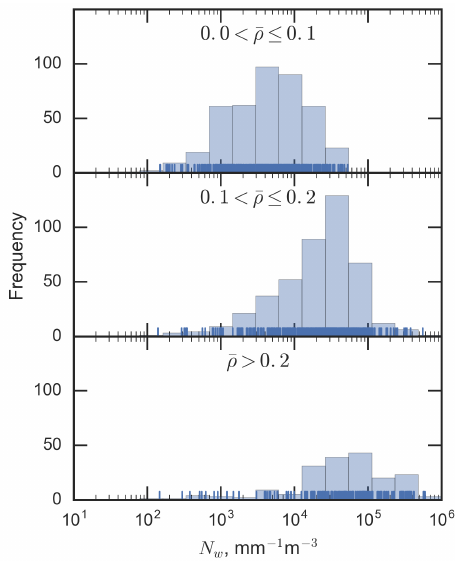
Figure 13. Frequency of N w in three ensemble mean density ranges, [ ρ ] = gcm − 3